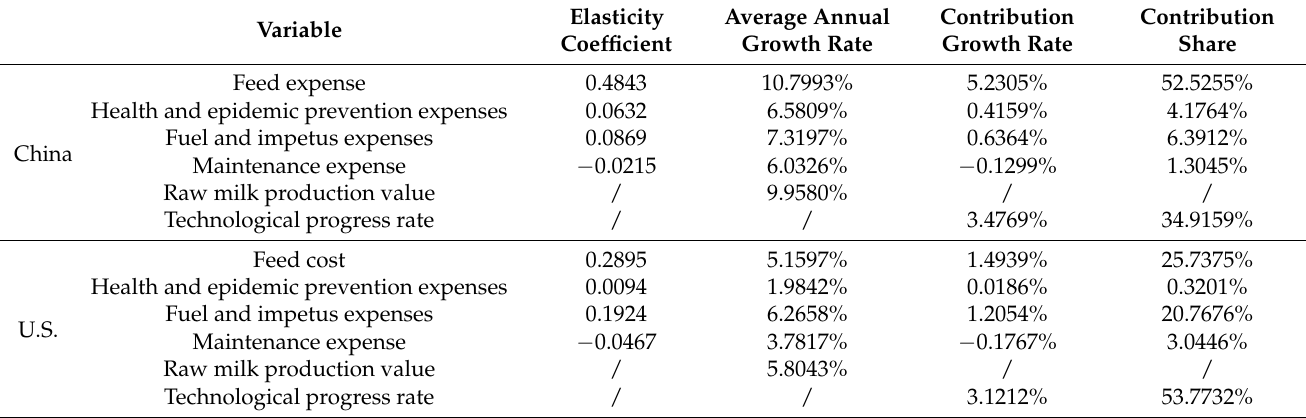
Table 2. Contribution of input factors to the growth of raw milk output